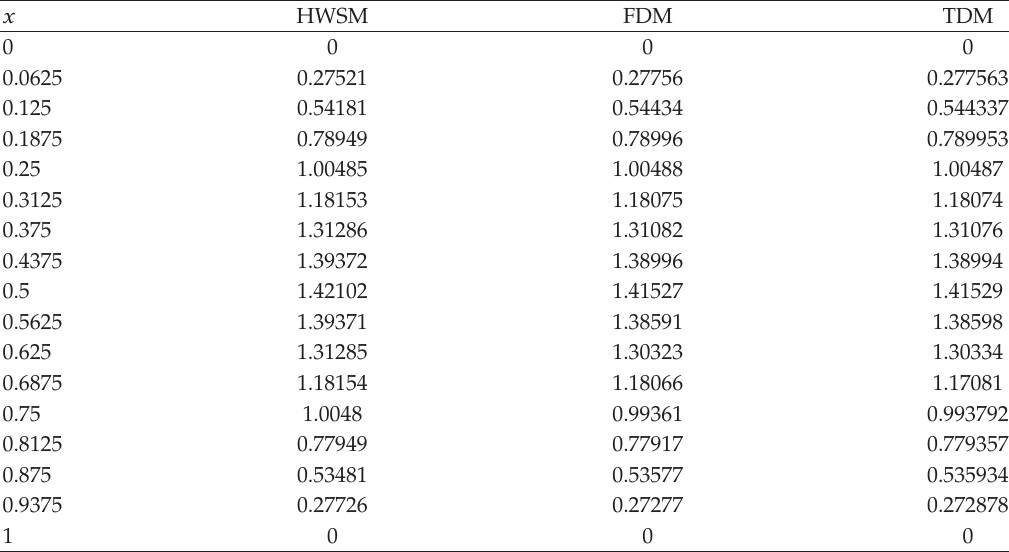
Table 3: Comparison of the first eigenvalue and solutions of Example 3.1 using TDM and Table 4 from (cid:6) 9 (cid:7) , when p (cid:5) 16, n (cid:5) 2, and h (cid:5) 0 .